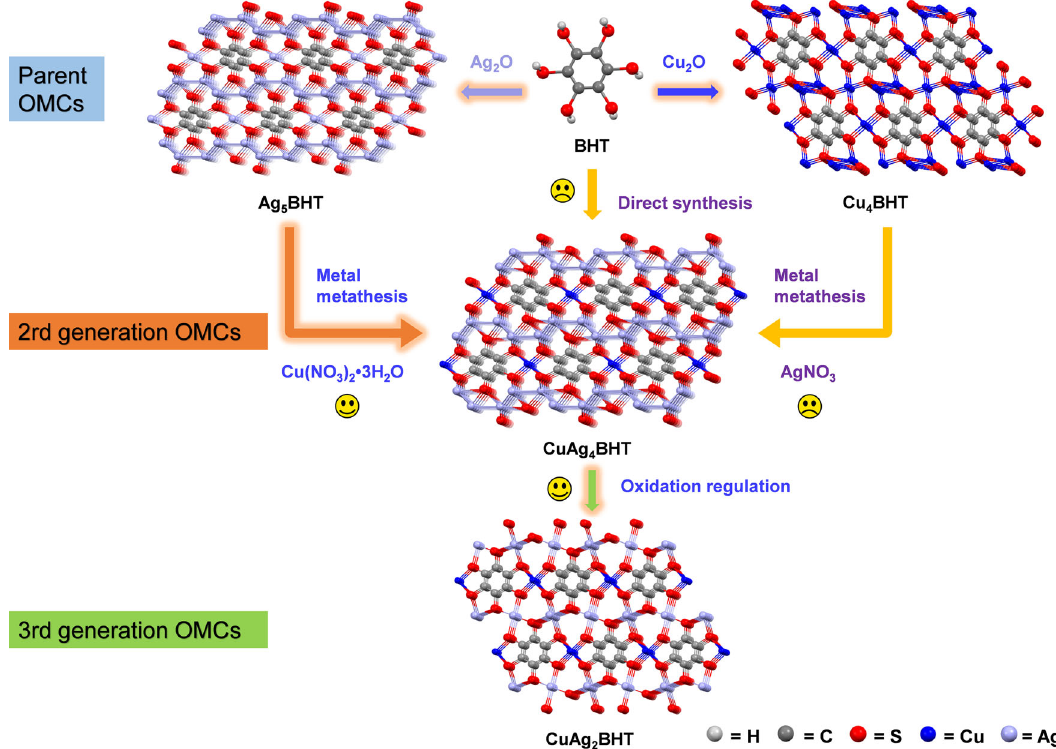
Fig. 1 | Synthetic scheme of bimetallic OMCs. Illustration of design strategies and synthetic routes of CuAg x BHTs ( x =4,